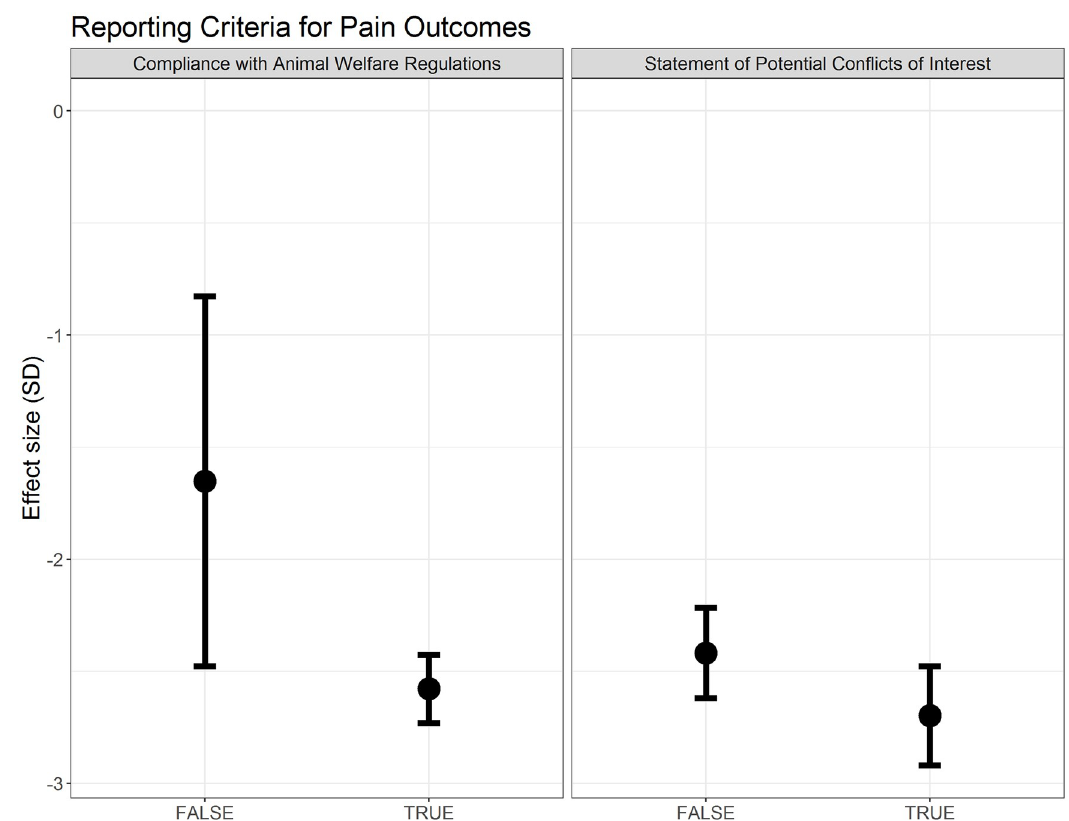
Fig 7. Effect sizes associated with reporting of compliance with animal welfare regulations and a statement of potential conflict of interests in modelling experiments using pain-related behavioural outcomes (data set 1a).